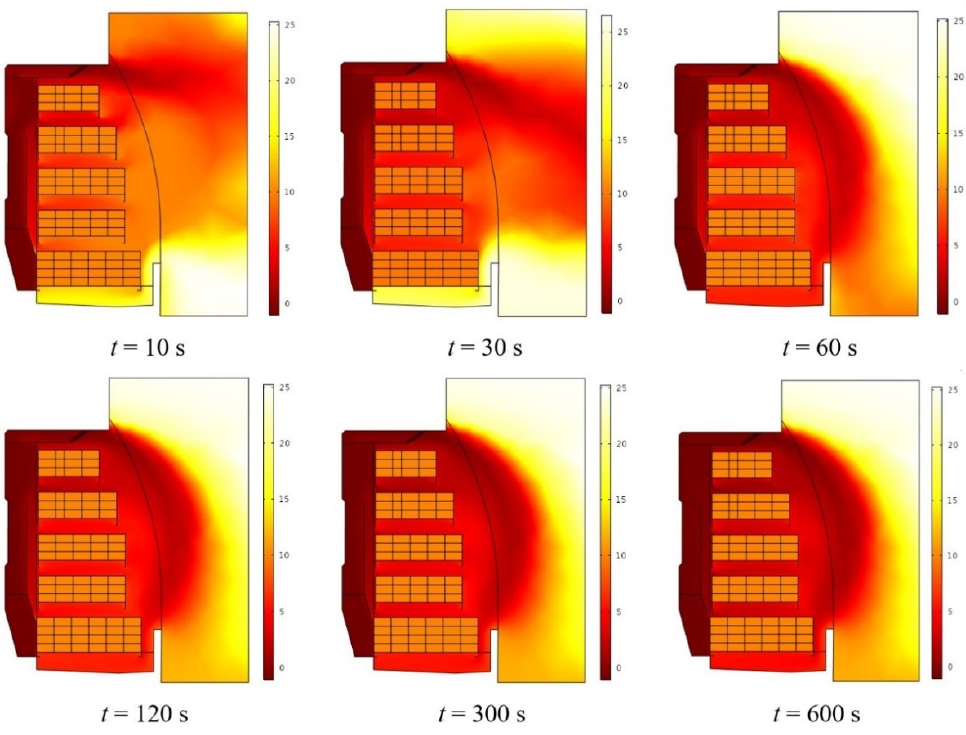
Figure 8. Temperature ( ◦ C) distribution in the middle plane of the unmodified cabinet.